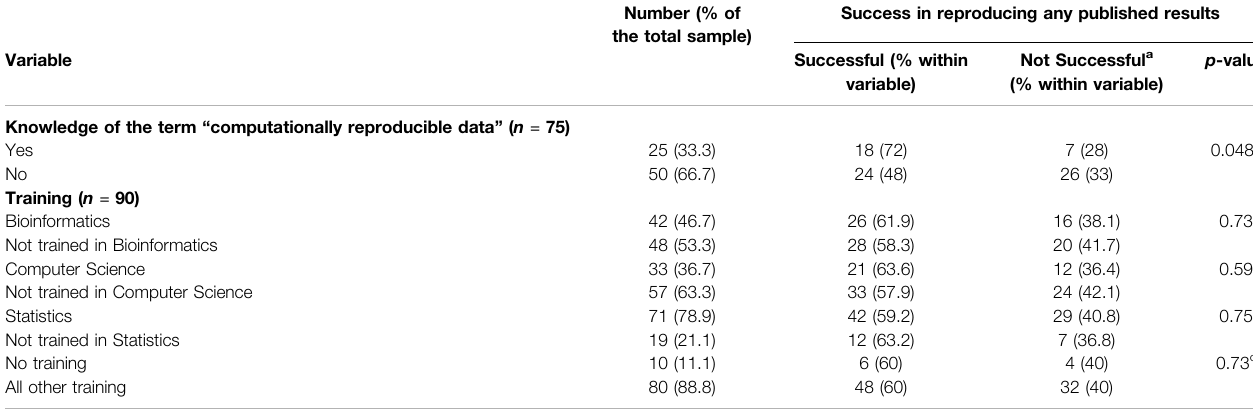
TABLE 2 | Success in reproducing any published results strati fi ed by their knowledge of the term “ computationally reproducible data ” and training